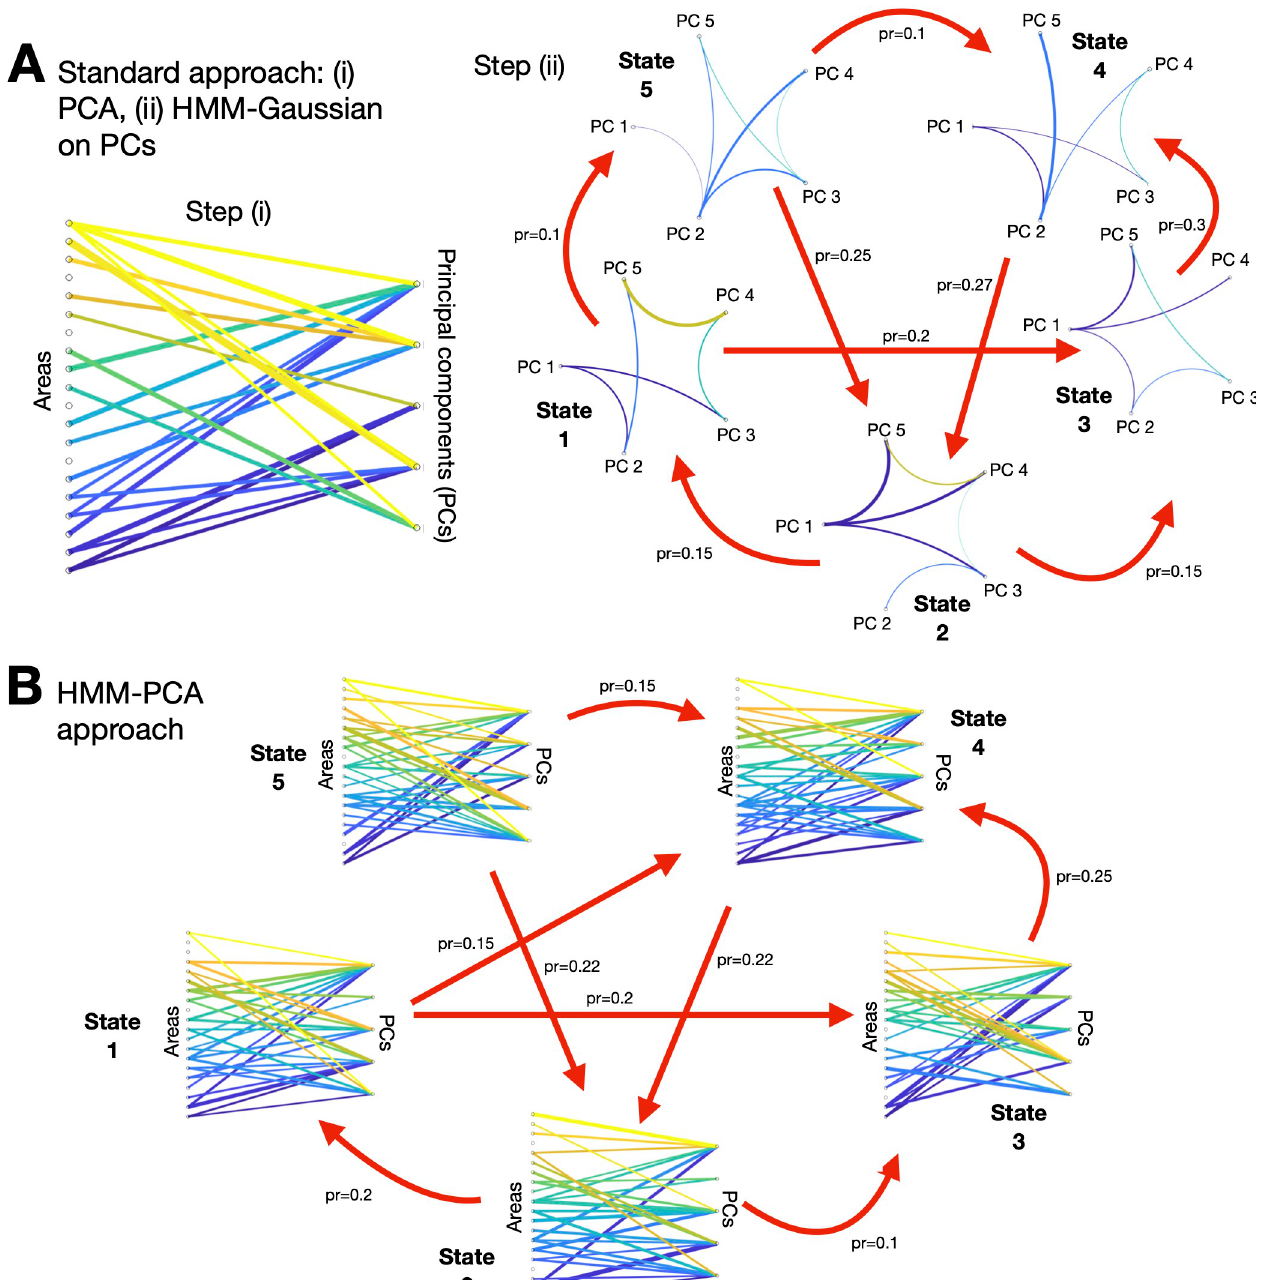
Fig 1. Two different approaches for the estimation of time-varying FC on high-dimensional fMRI data. A . PCA is first used as a dimensionality reduction step, blindly to the purpose of estimating time-varying FC; then, some state-based model (like the hidden Markov model) is run on the first principal components (PC). B . The HMM-PCA approach, where each state is a different PCA decomposition, is run directly on the high-dimensional data; given that the computation of PCA is based on the data covariance, different PCA decompositions capture different patterns of FC. See S1 Fig for representations in the form of graphical